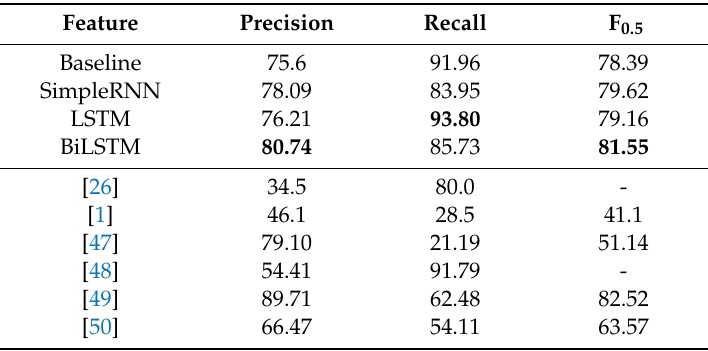
Table 5. Evaluation